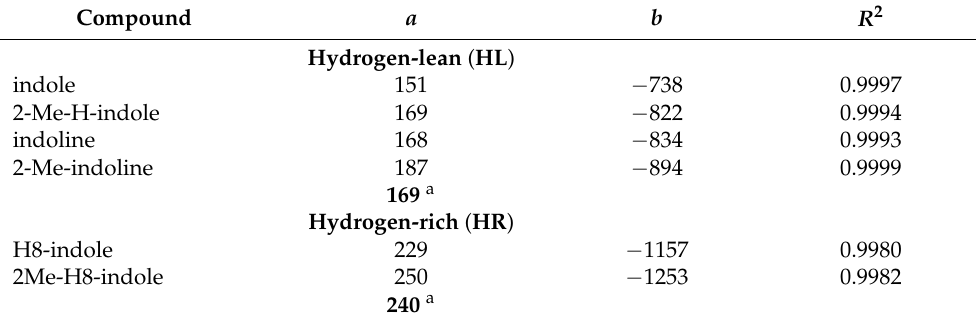
Table 16. Approximation of the temperature dependence of the heat capacity of HL and HR materials by the linear equation C o p ,m = a · ln ( T ) + b Compound a b R 2 Hydrogen-lean ( HL ) 151